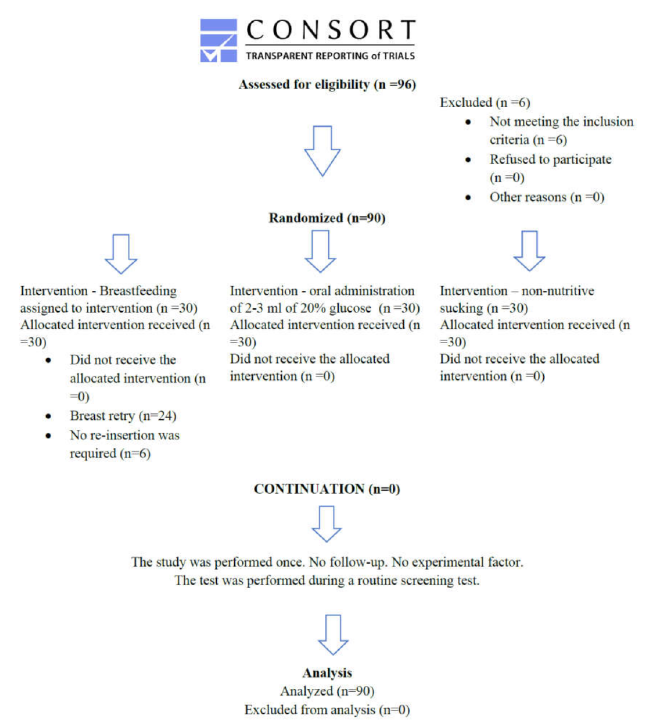
Figure 1. CONSORT